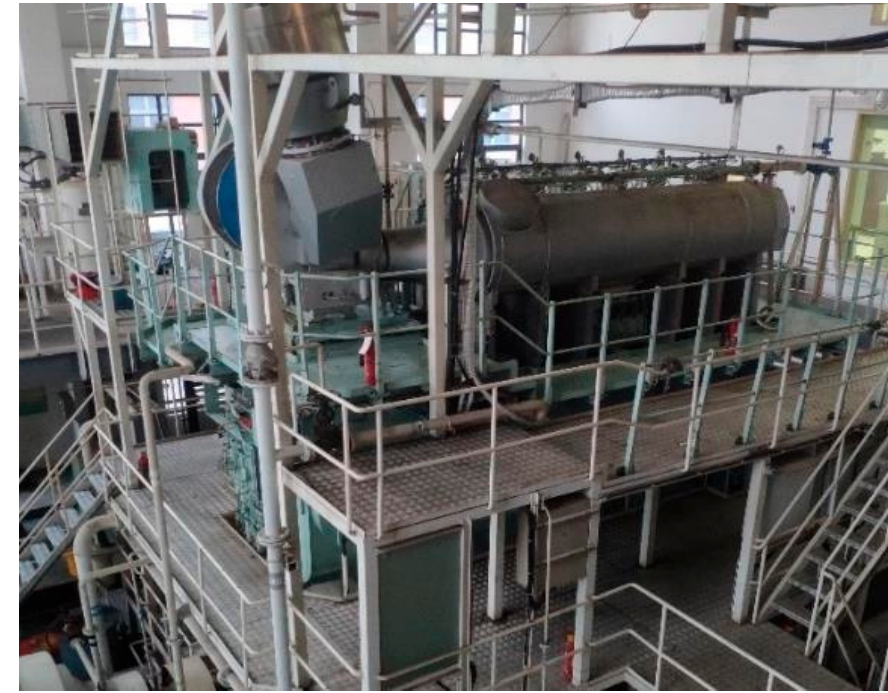
Figure 2. Ship diesel engine selected for the experiment.